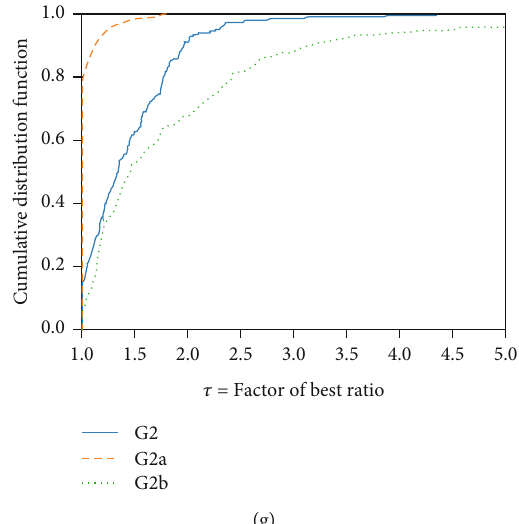
Figure 5: Performance pro fi les based on relative CPU time (s) for Question 5. (a) BLSP, (b) QMKP with positive coe ffi cients, (c) QMKP with mixed-sign coe ffi cients, (d) k QKP with positive coe ffi cients, (e) k QKP with mixed coe ffi cients, (f) HSP, (g) QSAP.